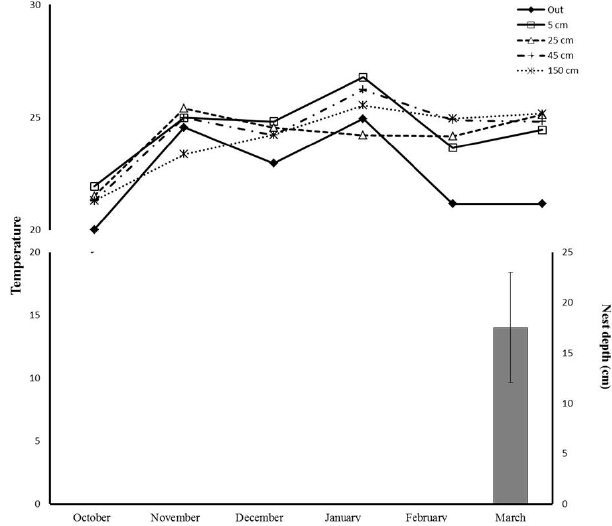
Fig 1. Mean temperature (°C) of soil and nest depth (cm± SD) of initial nest of Atta sexdens for six months after nuptial